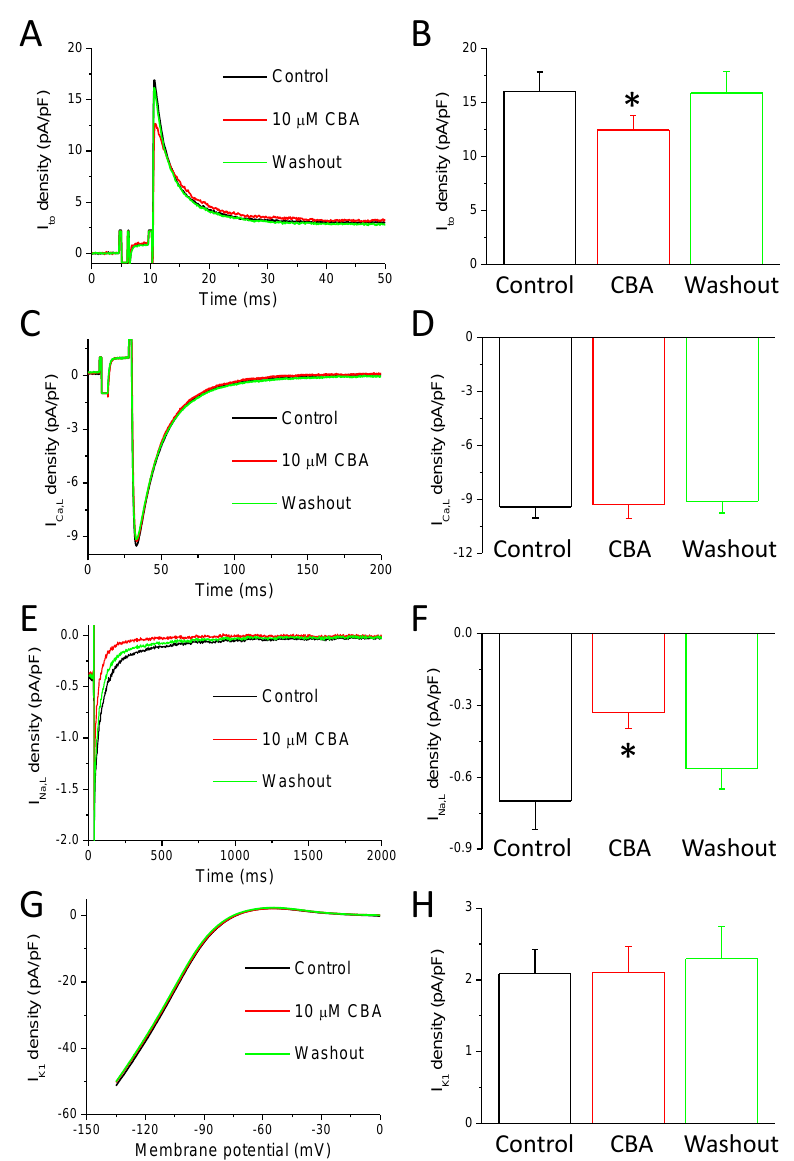
Figure 6. Effects of CBA in ionic currents evoked by conventional voltage-clamp technique. Current traces recorded in control conditions (black), in the presence of CBA (10 µM, red), and after washout of CBA (green). A : Representative I to currents. B : Average ± SEM values of current density values in the indicated conditions of I to obtained in seven examined cells obtained from five animals. C : Representative I Ca,L currents. D : Average ± SEM values of current density values in the indicated conditions of I Ca,L obtained in eight examined cells obtained from four animals. E : Representative TTX-sensitive (I Na,L ) currents. F : Average ± SEM values of current density values in the indicated conditions of I Na,L obtained in nine examined cells obtained from five animals. G : Representative BaCl 2 -sensitive (I K1 ) currents. H : Average ± SEM values of current density values in the indicated conditions of I K1 obtained in seven examined cells obtained from four animals. Asterisks show statistically significant differences compared to the control.